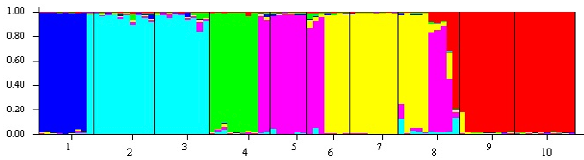
Figure 6. STRUCTURE plot of the studied P. afra populations.